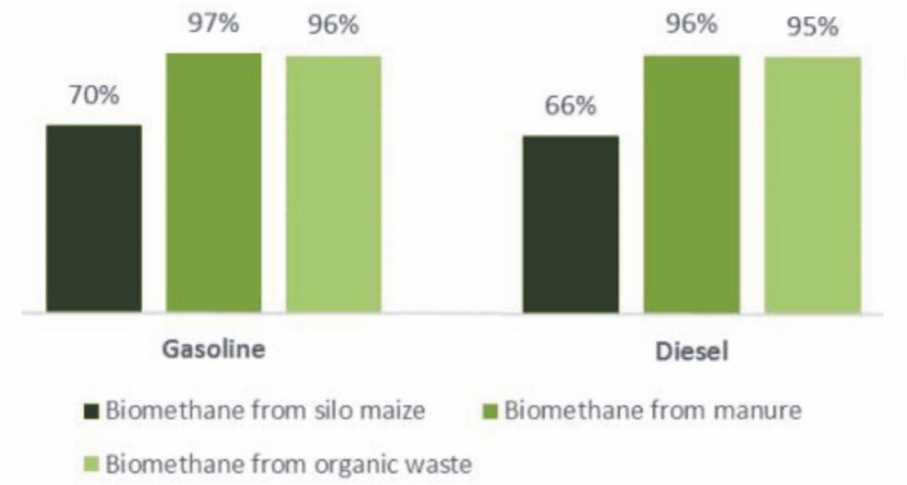
Figure 17. Well-to-wheel GHG emission reduction potential of BM compared to diesel/gasoline; own elaboration based on